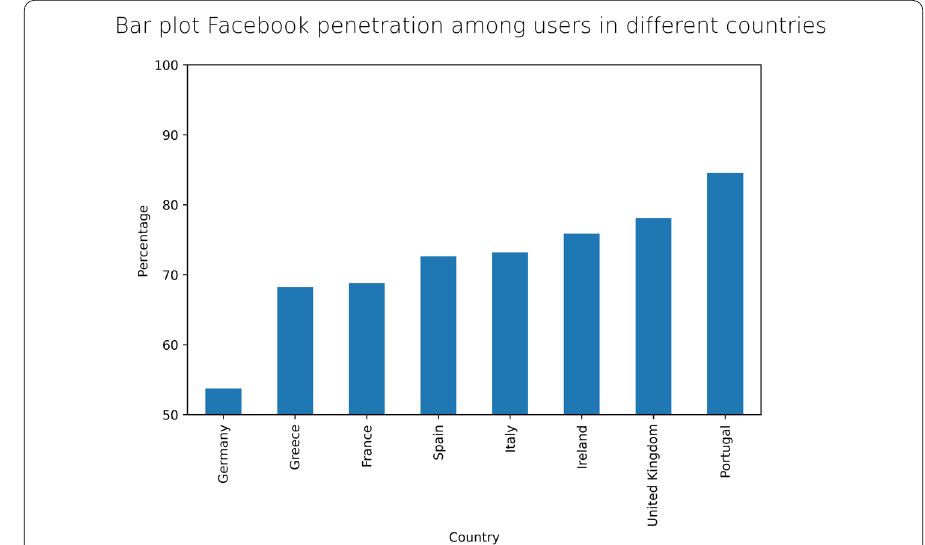
Figure 2 Facebook penetration in euroupian countries